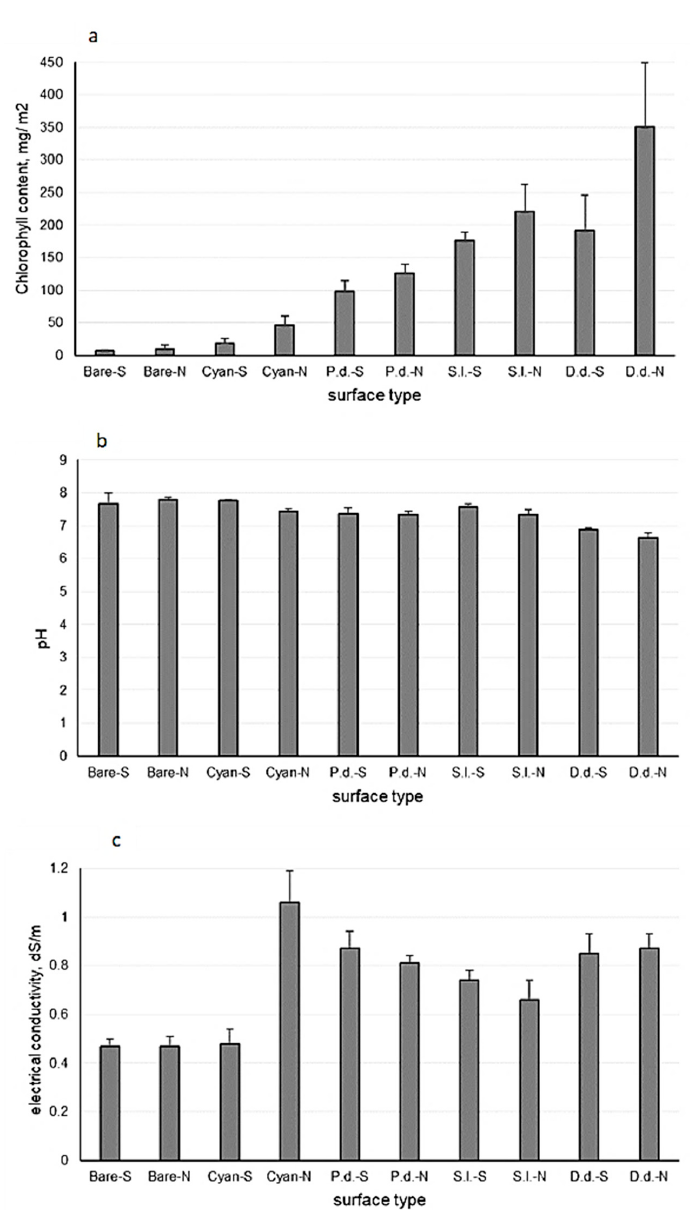
Figure 3. ( a ) Chlorophyll a content, ( b ) pH, and ( c ) electrical conductivity in different crust types